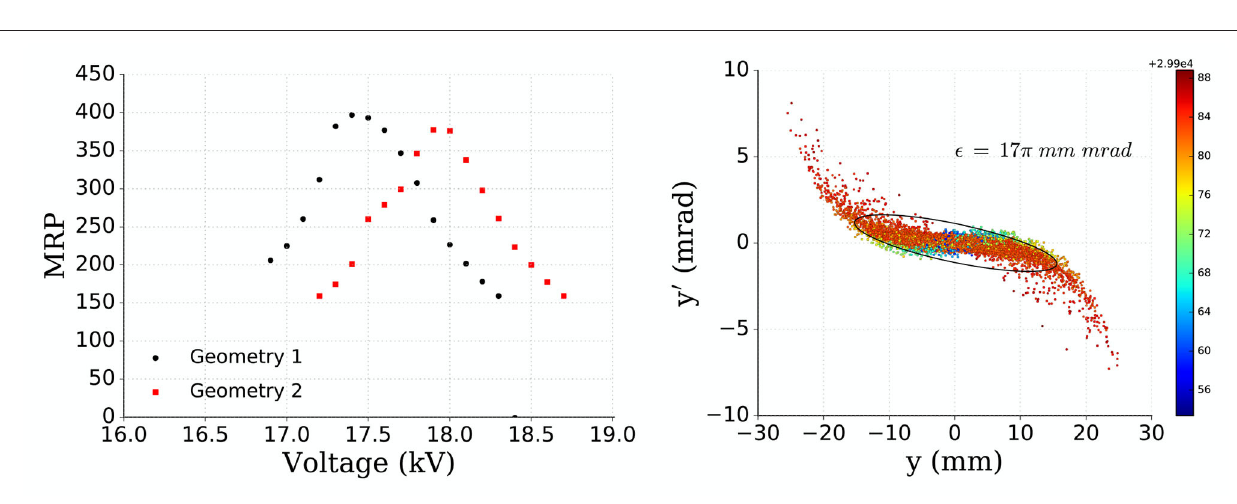
FIGURE 5 | MRP vs. einzel lens voltage for geometry 1 (black circles) and geometry 2 (red squares). These geometries differ in the position of the einzel lens within the beamline, geometry 2 having the einzel lens further away from the ion source (Left) . Beam emittance for geometry 2 (final geometry) with the ellipse encompassing 95 % of the simulated events. The colorbar is the energy range of the particles: 2.99e4 + 0.0056 keV to 0.0088 keV (Right)